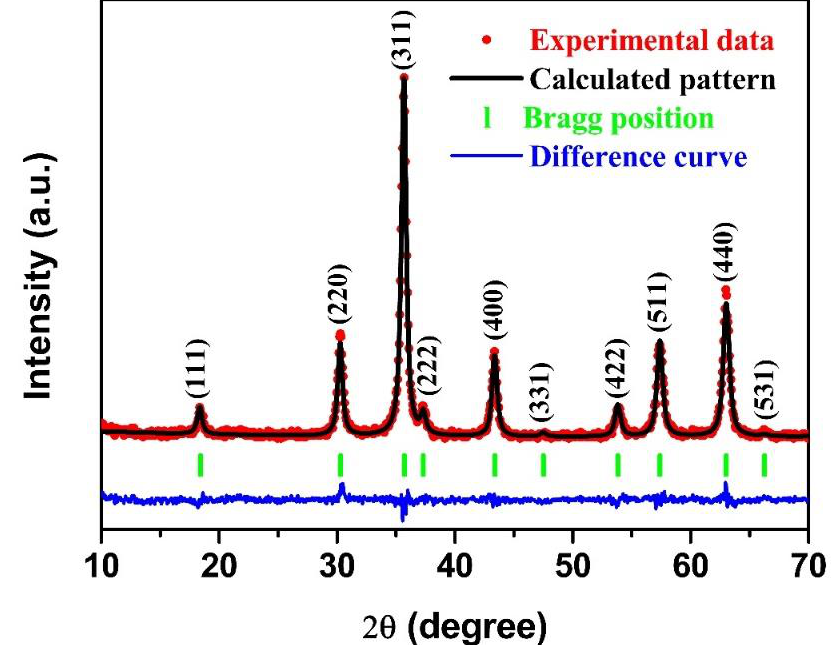
Figure 3. XRD patterns for the experimental and Rietveld refinement data for the NiFe 2 O 4 nano-octahedrons.